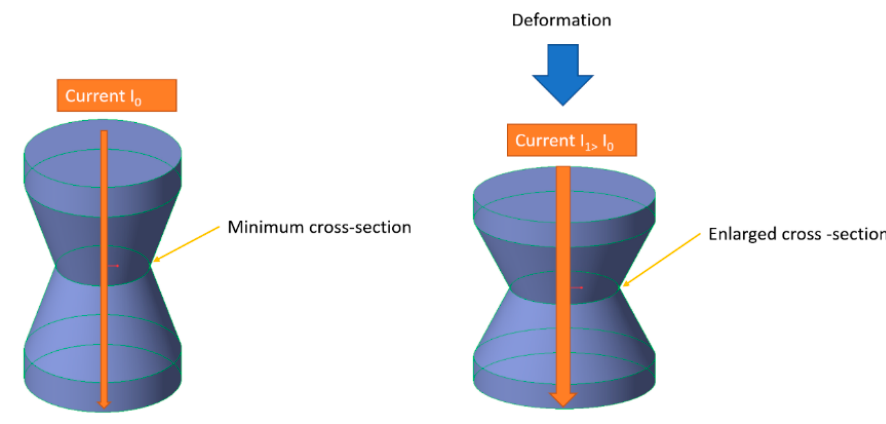
Figure 1. Principle of the 3D-printed transducer.